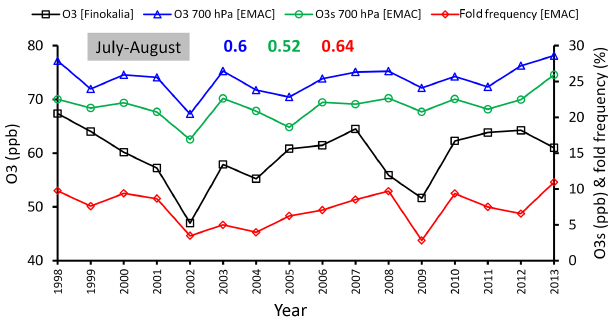
Figure 8. Time series over the period 1998–2013 of July–August average values for observed near-surface ozone at Finokalia Crete (black squares), EMAC-simulated ozone at 700hPa over EM (blue triangles, 20–30 ◦ E, 30–40 ◦ N), EMAC-simulated O 3 s at 700hPa over EM (green circles, 20–30 ◦ E, 30–40 ◦ N) and tropopause fold frequency over SB (red diamonds, 20–27 ◦ E, 37–44 ◦ N). The col- ored numbers above the lines are the correlation coefficients be- tween July–August average values of near-surface ozone at Fi- nokalia and EMAC-simulated O 3 at 700hPa over EM (blue); EMAC-simulated O 3 s at 700hPa over EM (green); tropopause fold frequency over SB (red) respectively.